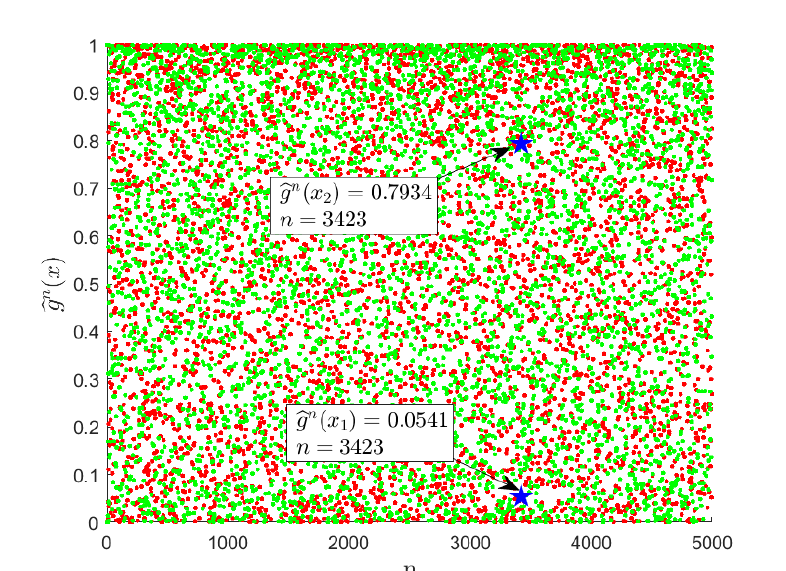
Figure 2. The chaotic behavior of (cid:98) g ( x 1 = 0.50001, x 2 = 0.50002, the number of iterations n = 5000).